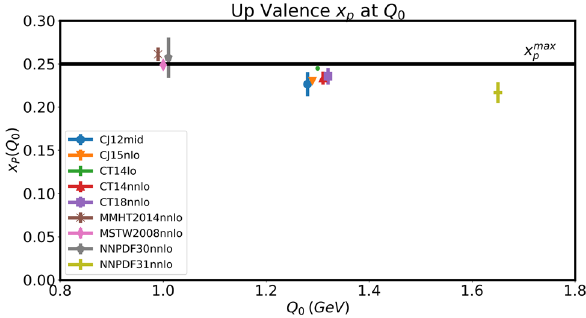
Fig. 11 The position of the peak of xq v distribution for valence u- quarks at different starting Q 0 . References